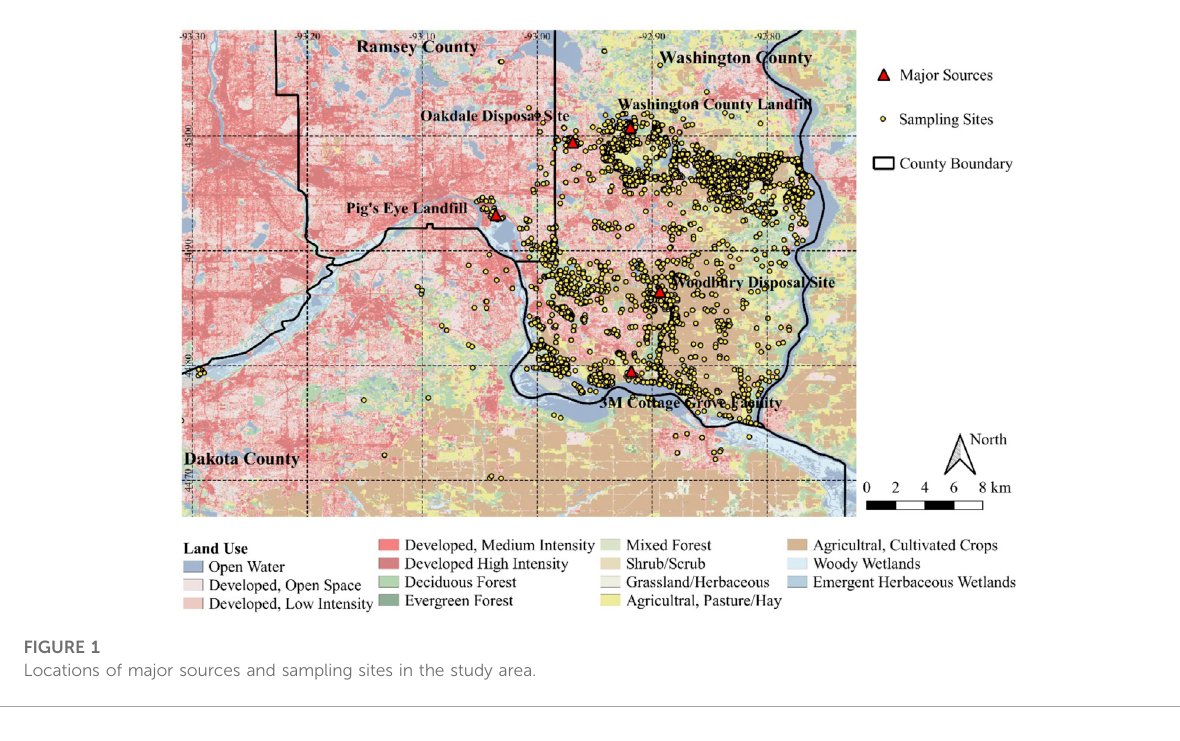
FIGURE 1 Locations of major sources and sampling sites in the study area.